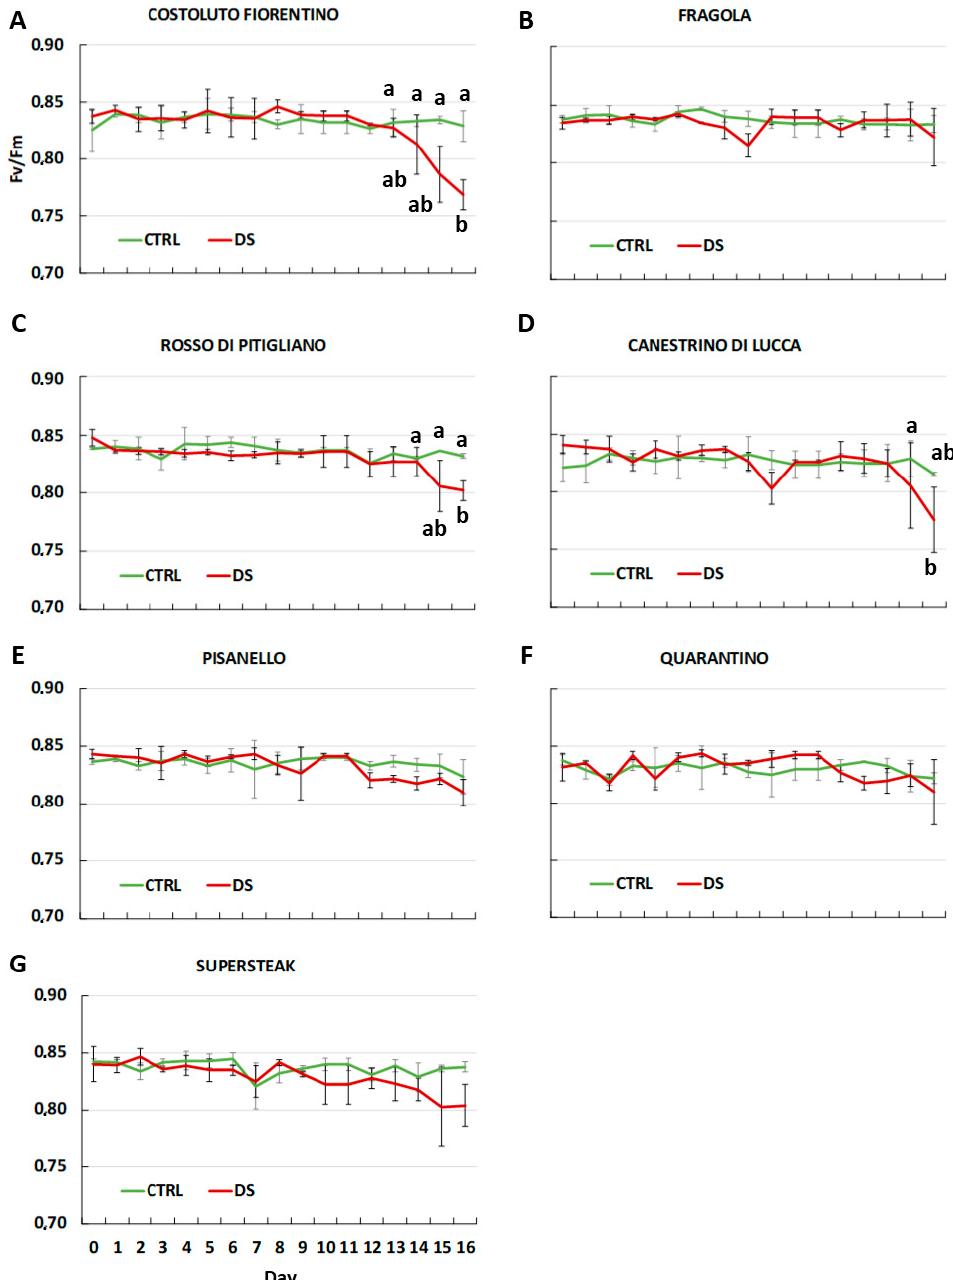
Figure 2. The maximum quantum yield of photosystem II (F v / F m ) in six local varieties ( A – F ) and one commercial cultivar ‘Supersteak’ ( G ) of tomato ( Solanum lycopersicum L.) subjected to drought stress (no water for 16 days) relative to the controls (regularly well-watered plants). Two-way factorial ANOVA followed by Tukey post-hoc test was used to determine the statistical significance of di ff erences. Points with the same lower-case letters do not di ff er significantly ( p > 0.05).